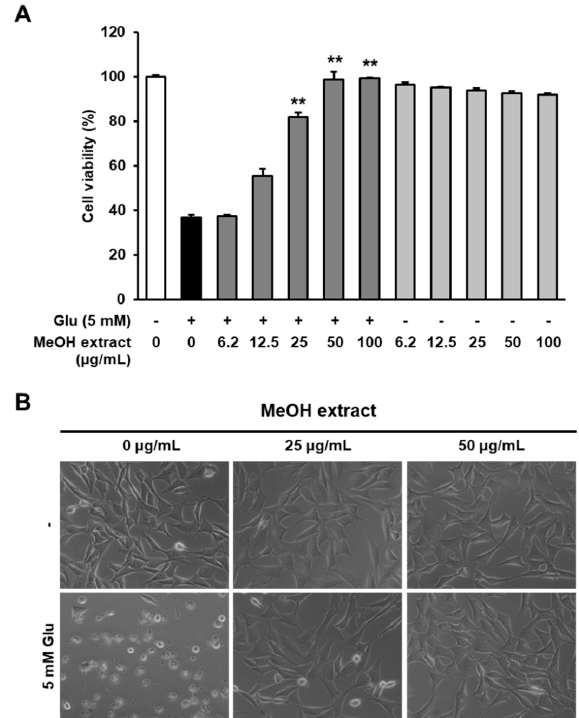
Figure 1. MeOH extract of R. elliptica seeds protect HT22 cells from glutamate-induced toxicity. ( A ) HT22 cells were exposed to the indicated concentrations of the MeOH extract of R. elliptica seeds with or without 5 mM glutamate (Glu) for 24 h. Bars denote the percentage of viable cells (** p < 0.001 compared with glutamate-treated group). ( B ) Morphological changes are represented by microscopic images (40 ×